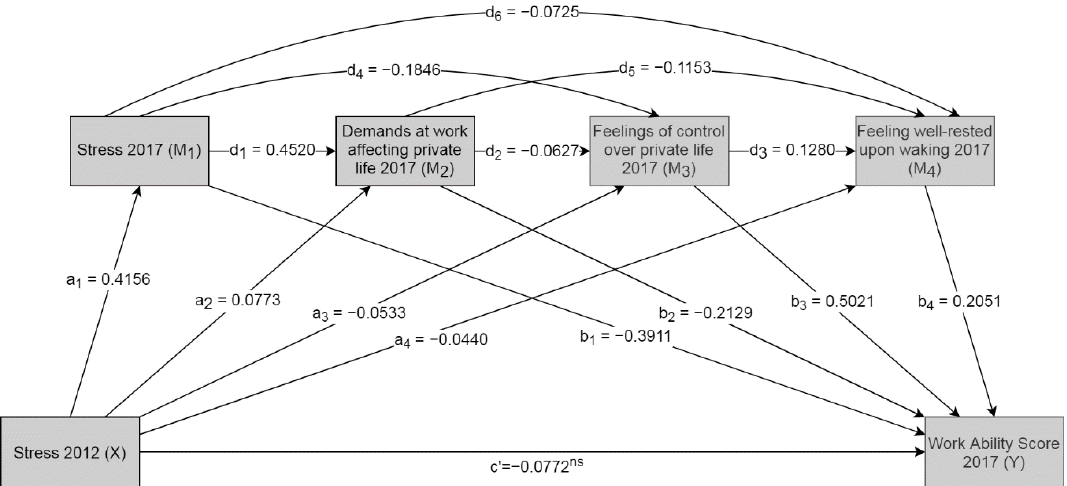
Figure B1. Quadruple mediation with individual effect per path. All paths are significant p < 0.05, Figure A3. Quadruple mediation with individual e ff ect per path. All paths are significant p < 0.05, except c’. except c (cid:48)